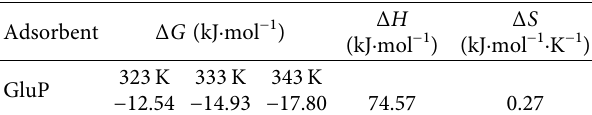
Table 5: Thermodynamic parameters for removal of Congo red